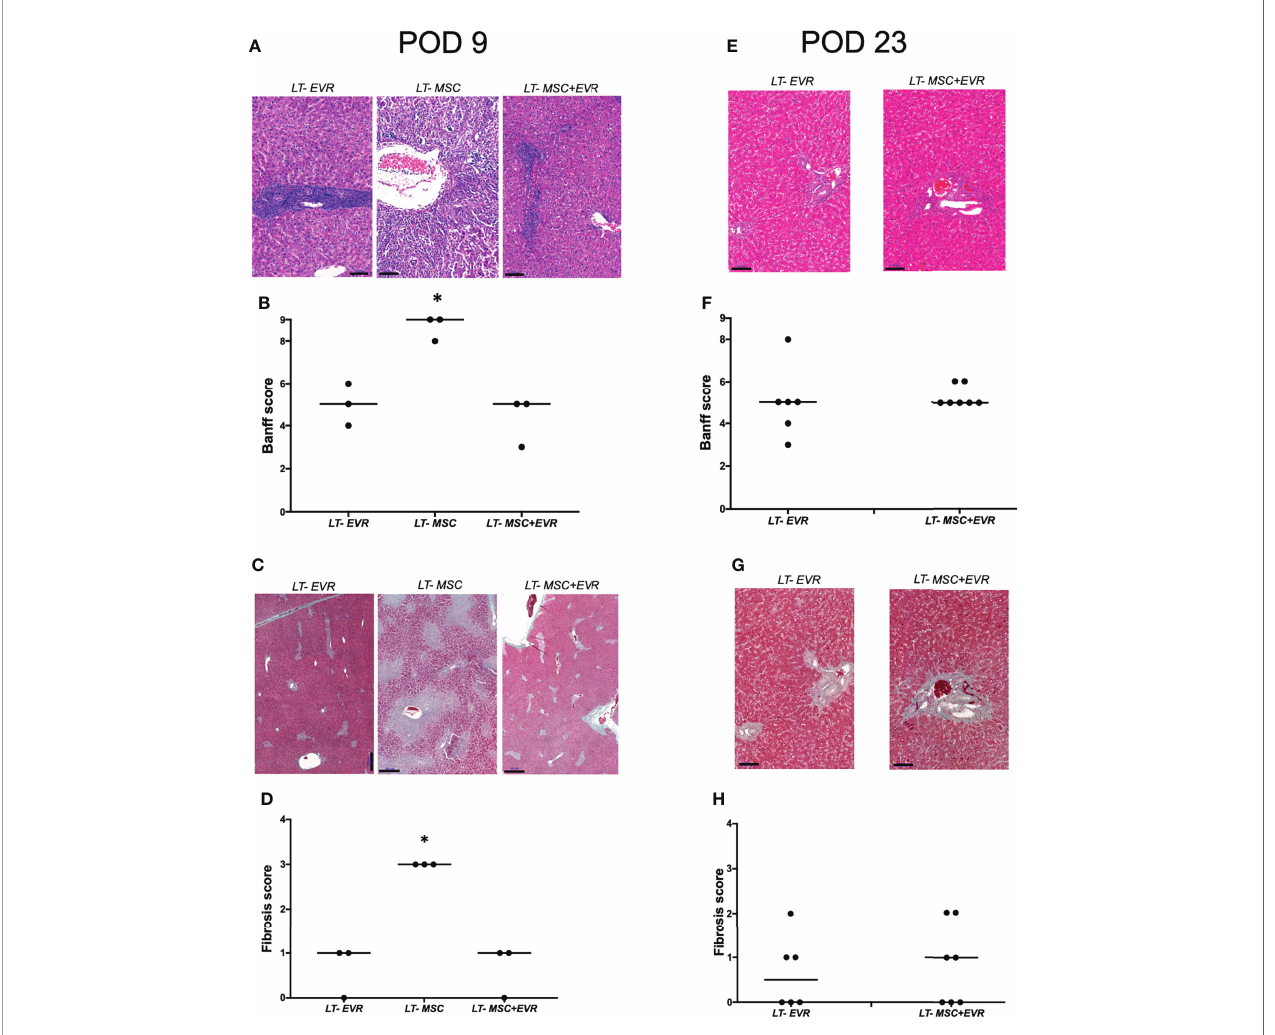
FIGURE 7 | Histological analysis. (A) H&E staining of liver graft and, (B) histological grading of liver graft acute rejection severity using Banff schema at D9 post-LT; (C) Masson ’ s trichrome staining highlighting liver graft fi brosis lesions (D) Histological grading of liver graft fi brosis severity with METAVIR score at D9 post-LT; (E) H&E staining of liver graft and, (F) histological grading of the severity of acute liver graft rejection using Banff schema at D23 post-LT; (G) Masson ’ s trichrome staining highlighting liver graft fi brosis lesions and (D) histological grading of liver graft fi brosis severity with METAVIR score at D23 post-LT. [* P < 0.05; (B, D) Kruskal-Wallis